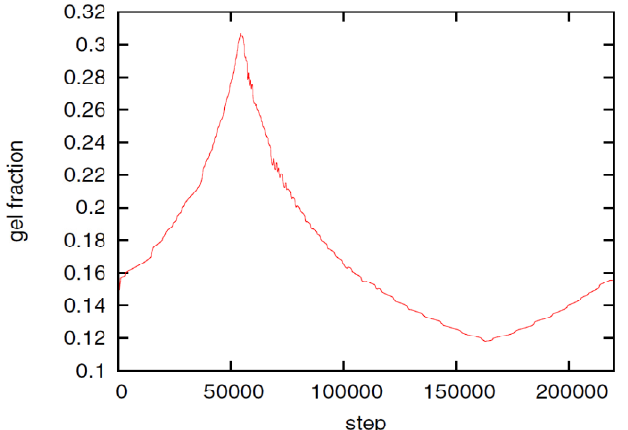
Figure 3. Evolution of the gel fraction with time. In the shown time period, the boundary ion concentration is linearly decreased from ion concentration is linearly decreased to , and decreased again to 289, 2011, 513-521, Phase field stimulation, Li, D., Yang, H.L., Emmerich, H., kind permission from Springer Science+Business Media B.V.